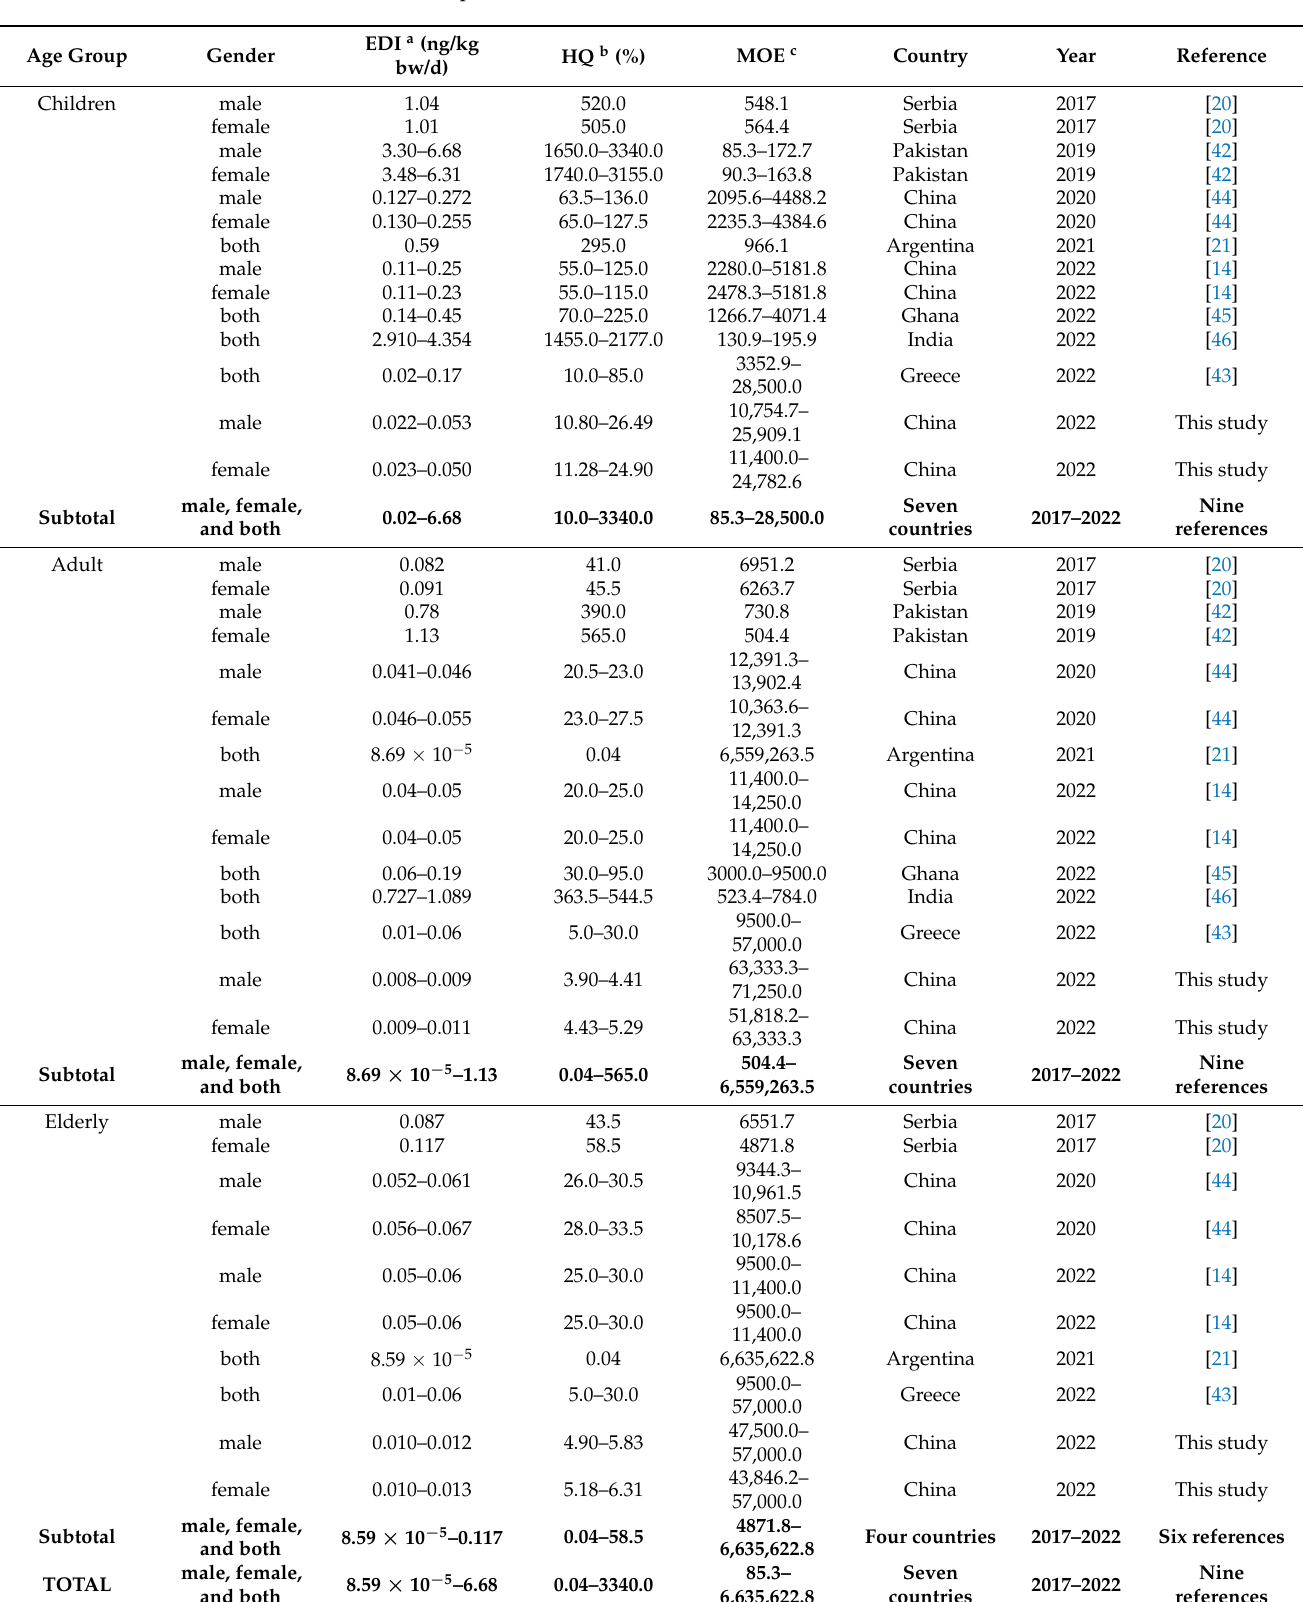
Table 5. Review of the EDIs, HQs, and MOEs of AFM1 in three age groups of male and female milk consumers in previous